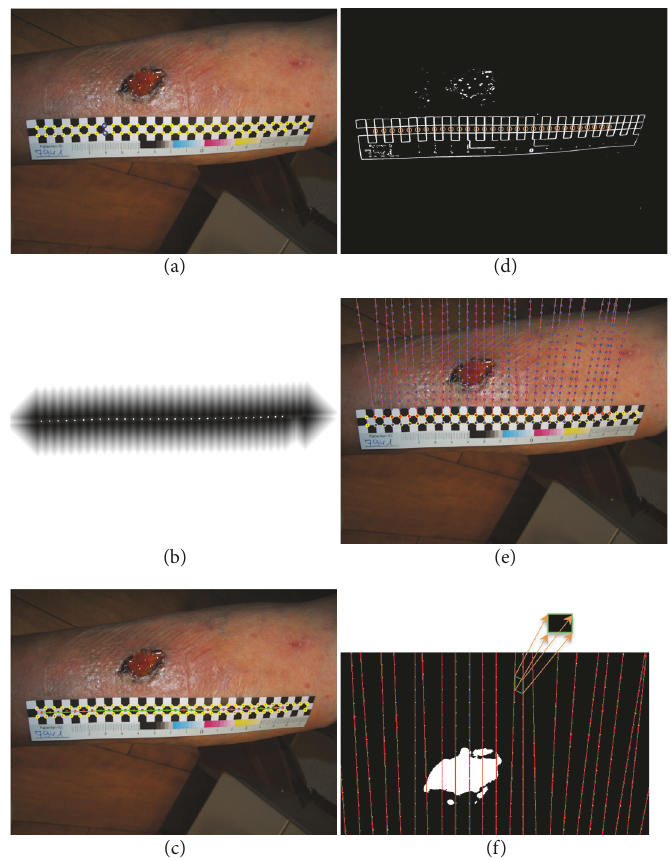
Figure 3: (a) Identified checkboard points and two corresponding corner points 𝑝 1 and 𝑝 2 shown with blue circles. (b) The result of applying DT filter on the corner points. The white dots show the computed local maxima. (c) The fitted curve to the local maxima of the distance transform point result (cline). (d) The red circle windows are applied at the location of each detected intensity change in the high eigenvalue image. (e) Creating a grid pattern by extrapolating each pair of corresponding points over the wound. (f) Each quadrilateral in the grid is unwarped to a square with known size.